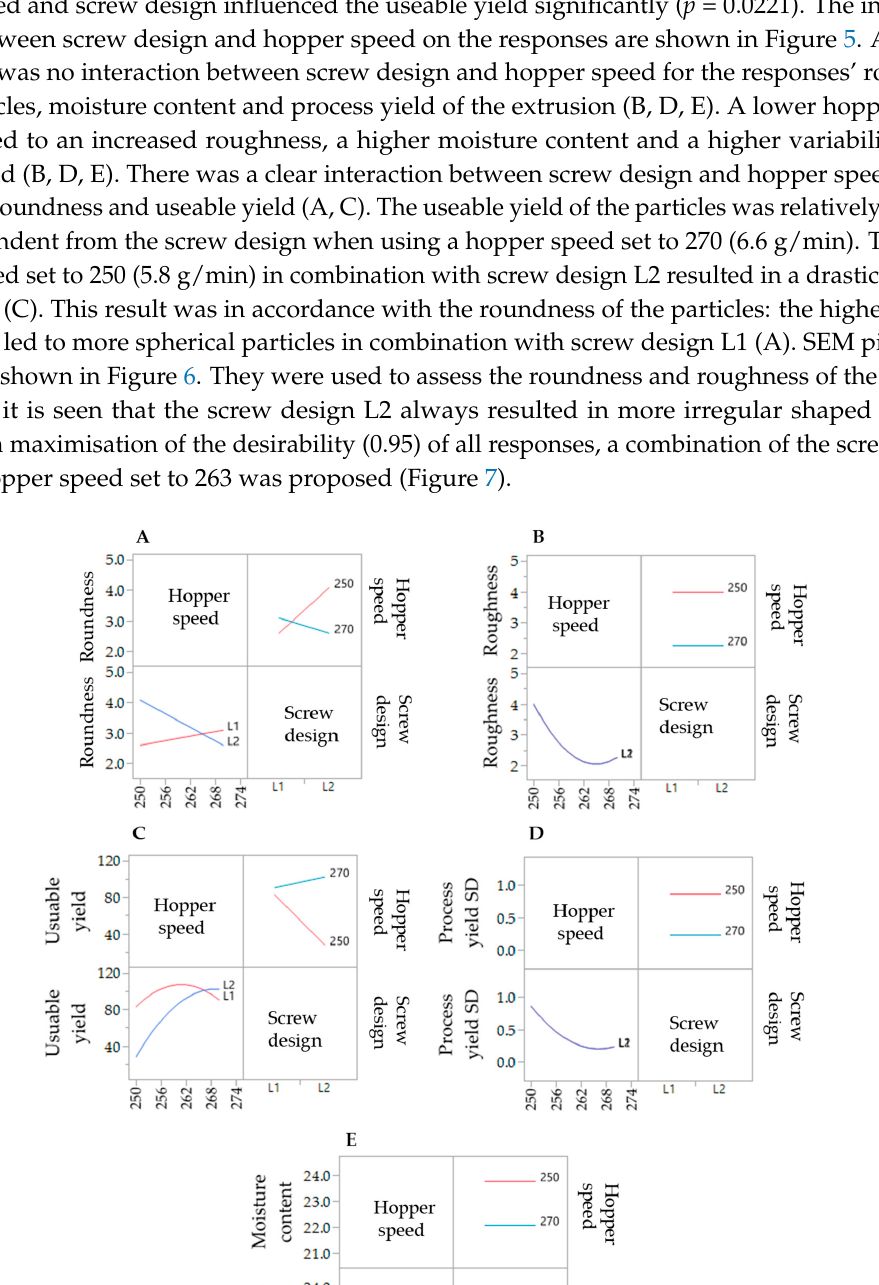
Table 1. Design of Experiment of the extrusion process and the resulted responses (for all runs the spheronisation process was constant with 9 min time, 75% speed and 15 g load).